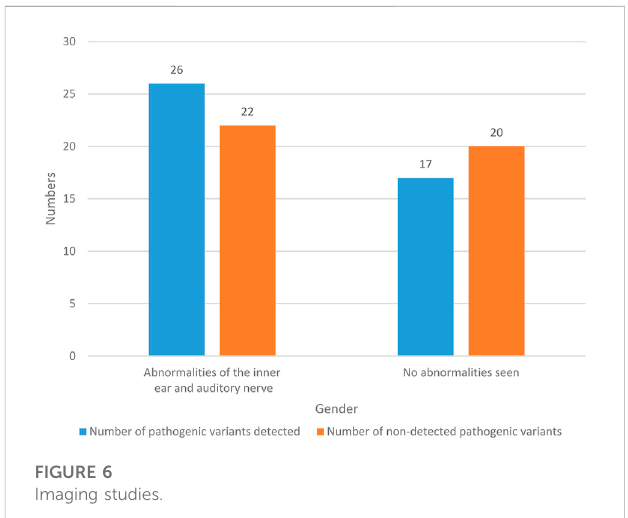
FIGURE 6 Imaging